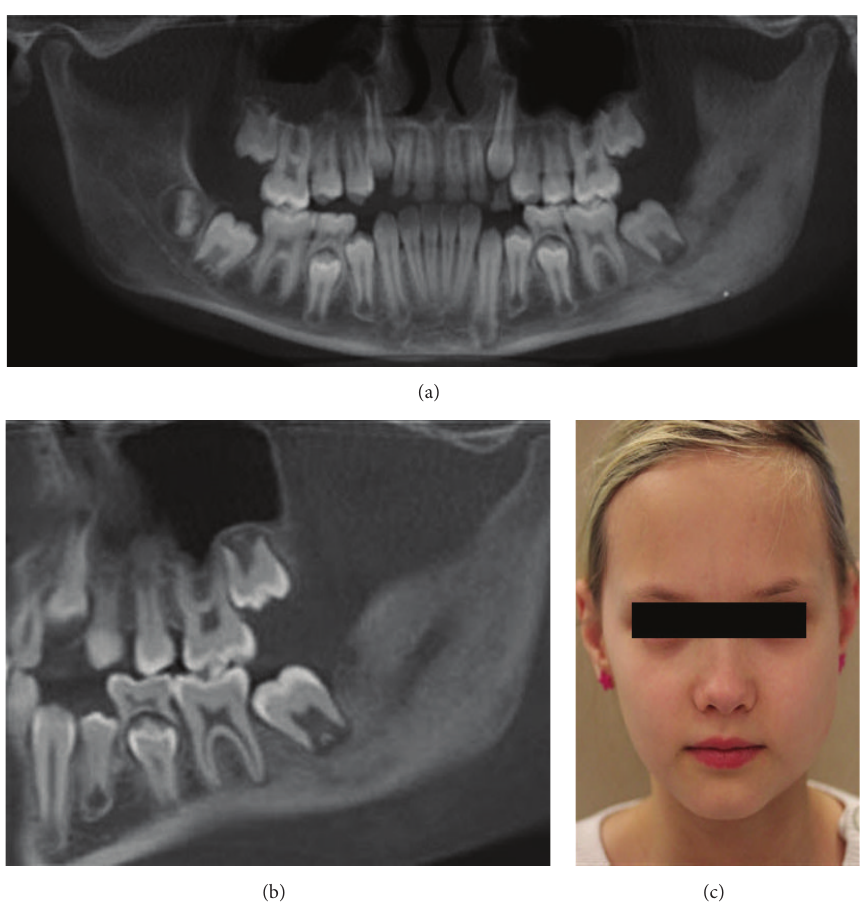
Figure 3: Six-month postoperative control CBCT and clinical image of patient case 1 with PCO. (a) Panoramic CBCT; (b) sagittal section of sclerotic mandible with no lytic lesion; and (c) patient photo, with reduced facial swelling at the left side.